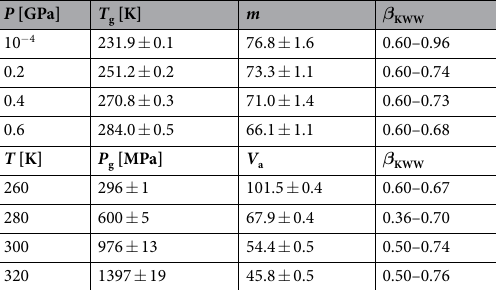
Table 1. Values of the glass transition temperature ( T g ) and pressure ( P g ), fragility ( m ), activation volume ( V a ) and range of β